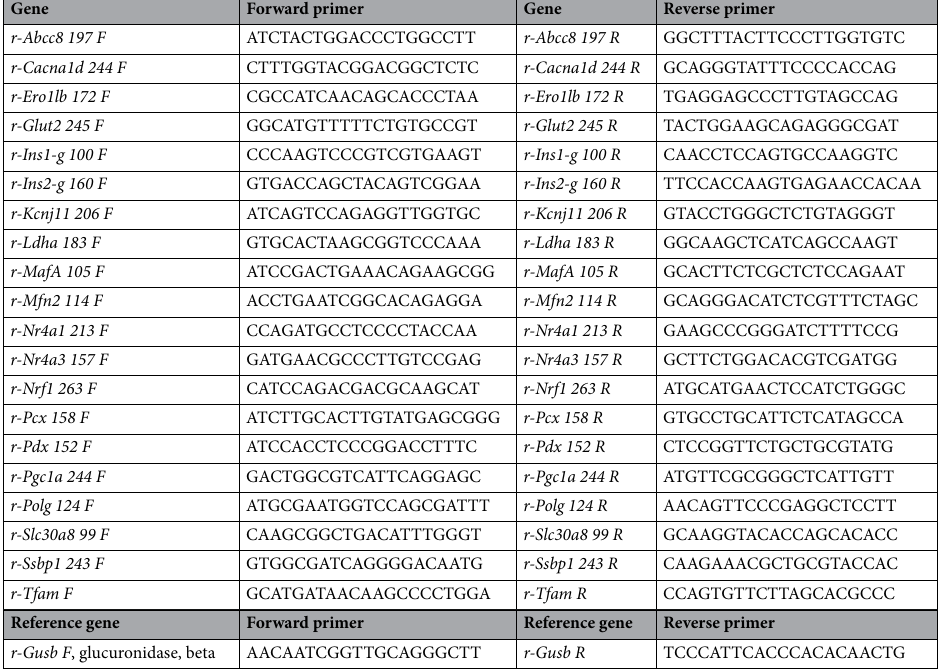
Table 1. Primers employed for tested rat (r) genes—in forward (F) and reverse (R) direction. For a reference gene, rat glucuronidase beta ( r-Gusb ) was